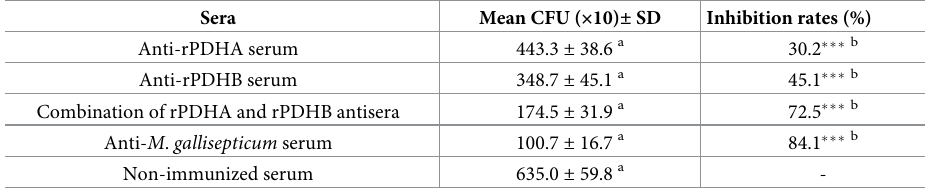
Table 3. Adherence inhibition rates of the